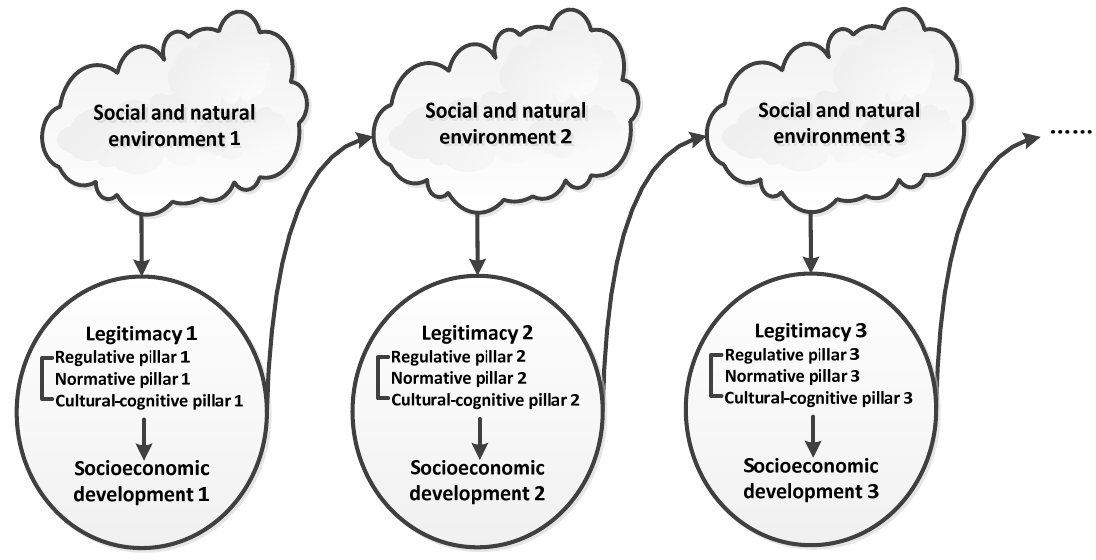
Figure 1. The legitimacy of a SEDP for socioeconomic development.